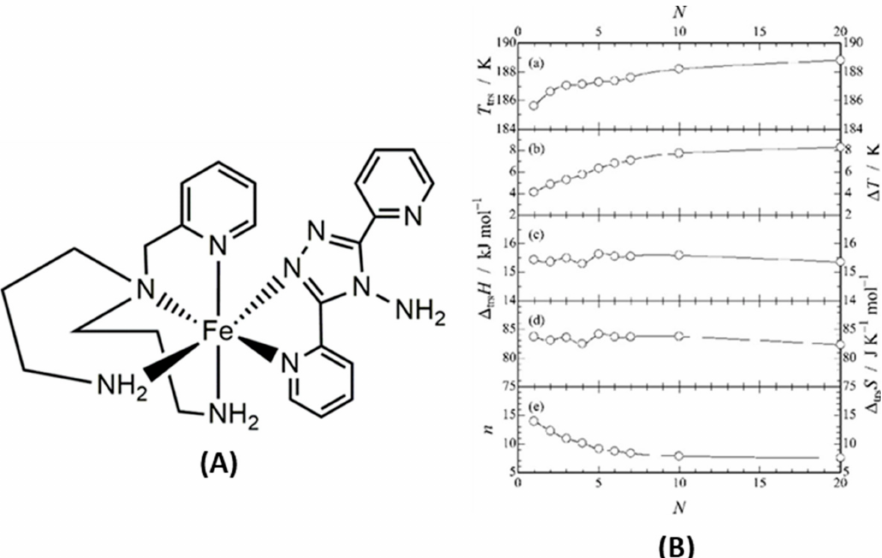
Figure 5. ( A ) Structural drawing of the complex [Fe II (DAPP)(abpt)](ClO 4 ) 2 (7), ( B ) Plots of transition temperature (a), full width half maximum (fwhm) of the ∆ Cp peak of the phase transition (b), transition enthalpy (c), transition entropy (d), and the number of molecules per domain by the domain model against number of experience of phase transition (e). ( B ) is reprinted with permission from ref. [41], copyright 2007, American Chemical